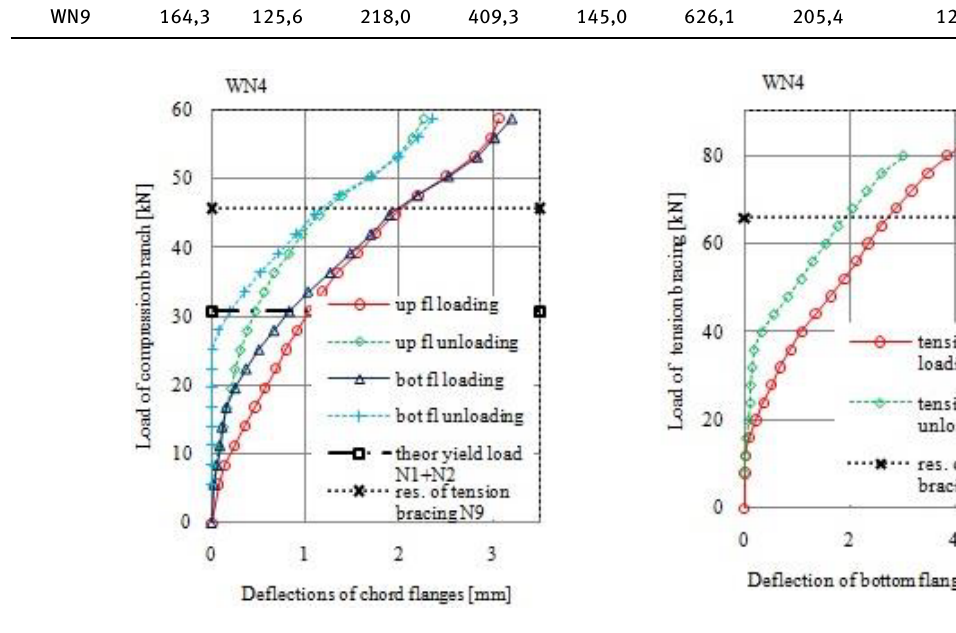
Figure 8: Load-deflection diagram for joint WN4 ( β = 0,4)